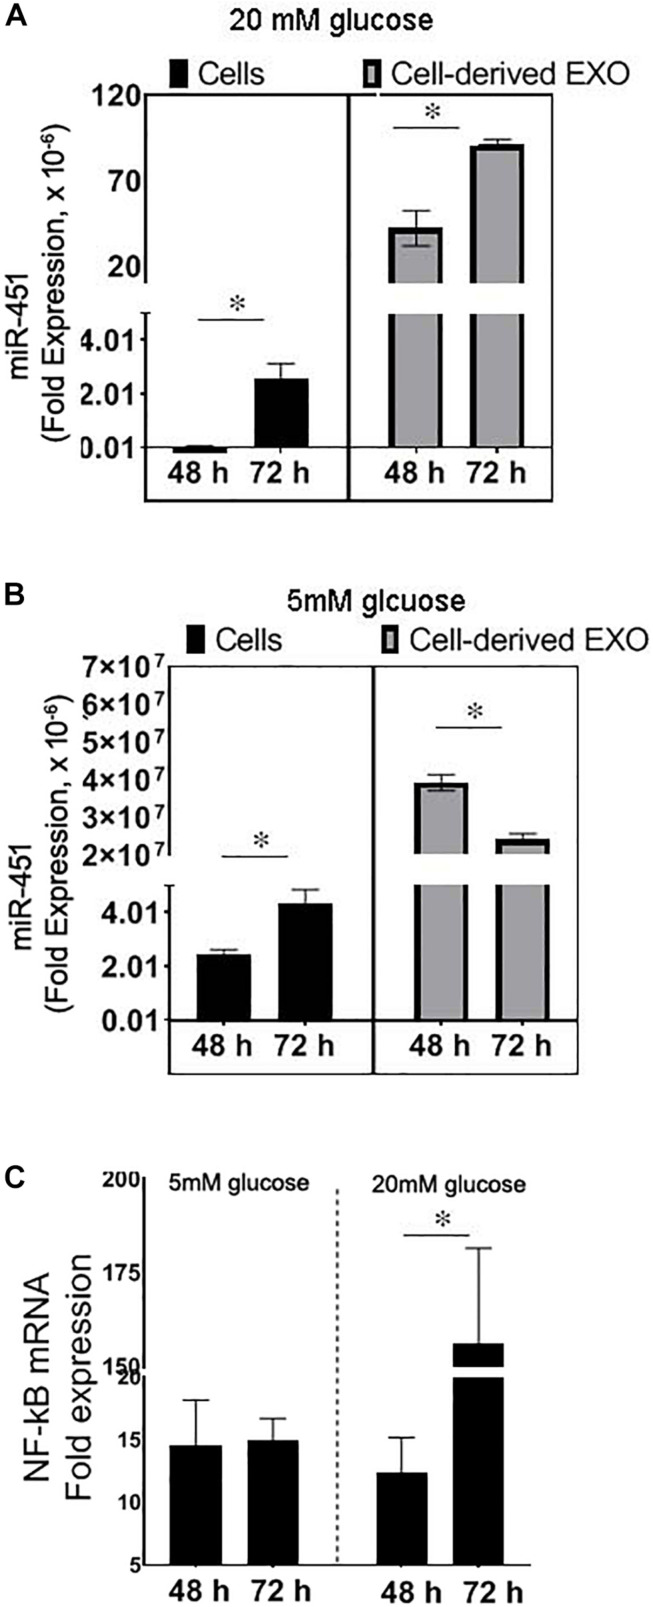
Effect of high-glucose-induced injury on miR-451 expression in primary human proximal tubule (hPT) cells and hPT-derived exosomes. Bar graphs show fold expression of (A,B) miR-451 in the hPT cells and hPT-derived exosomes in the media, (C) nuclear factor kappa-light-chain- enhancer of activated B cells (NF-κB) messenger RNA (mRNA) expression in hPT cells. Cells were cultured for 48 or 72 h in the medium containing high (20 mM) or normal glucose (5 mM). Gene expression were normalized against 18S ribosomal RNA using the formulae 2–ΔCT. Experiments were repeated three times. The data are represented as mean ± SEM. *p < 0.05 was considered significant by unpaired t-test.